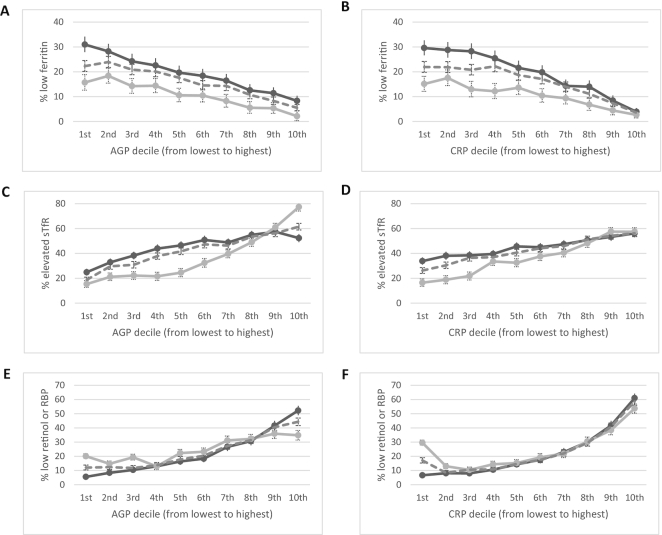
Estimated prevalence [% (95% CI)] of depleted iron stores, iron-deficient erythropoiesis, and vitamin A deficiency by inflammation deciles in children, BRINDA project. Estimated unweighted prevalence of depleted iron stores by AGP deciles (A) and CRP deciles (B), iron-deficient erythropoiesis by AGP deciles (C) and CRP deciles (D), and vitamin A deficiency by AGP deciles (E) and CRP deciles (F) in children. Depleted iron stores defined as ferritin <12 µg/L, iron-deficient erythropoiesis as sTfR >8.3 mg/L, and vitamin A deficiency as either retinol or RBP <0.7 µmol/L. Dashed line, pooled BRINDA phase 1 and 2 data; dark gray line, BRINDA phase 1 data; and light gray line, BRINDA phase 2 data. Sample size: (A, B) 8458 for BRINDA phase 1, 5610 for BRINDA phase 2, and 14,068 for BRINDA pooled; (C, D) 9326 for BRINDA phase 1, 4068 for BRINDA phase 2, and 13,394 for BRINDA pooled; (E, F) 8845 for BRINDA phase 1, 5572 for BRINDA phase 2, and 14,417 for BRINDA pooled. AGP, α-1-acid glycoprotein; BRINDA, Biomarkers Reflecting Inflammation and Nutritional Determinants of Anemia; CRP, C-reactive protein; RBP, retinol-binding protein; sTfR, soluble transferrin receptor.